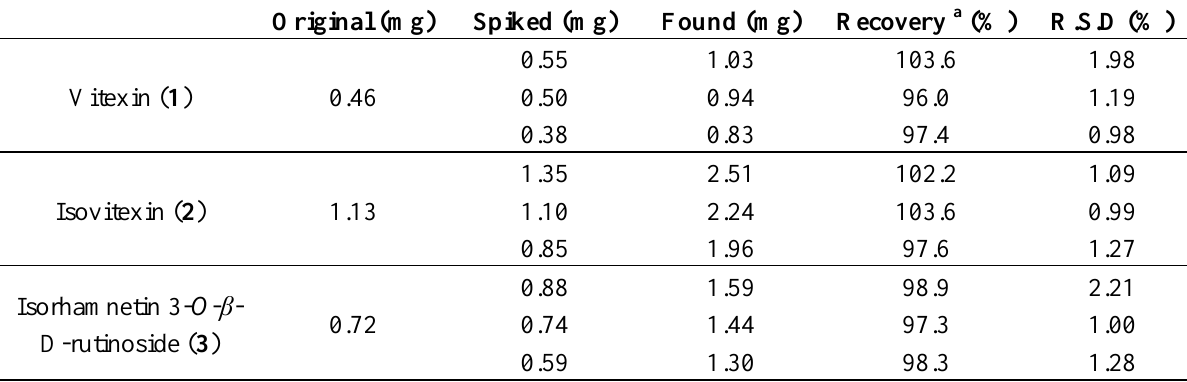
Table 2. Accuracy of HPLC method for the determination of the three flavonoid glycosides 1 – 3 .